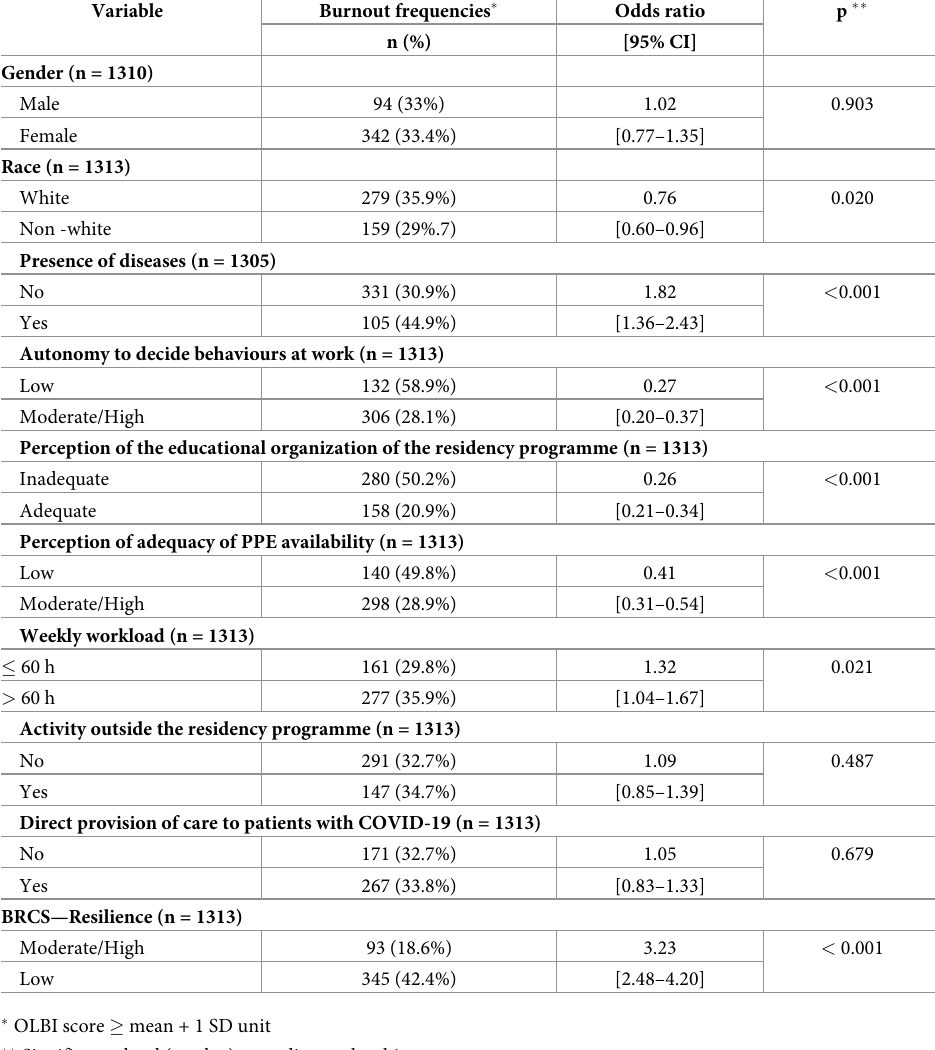
Table 4. Association between burnout (OLBI) and various characteristics of the participants—bivariate analyses (not adjusted).